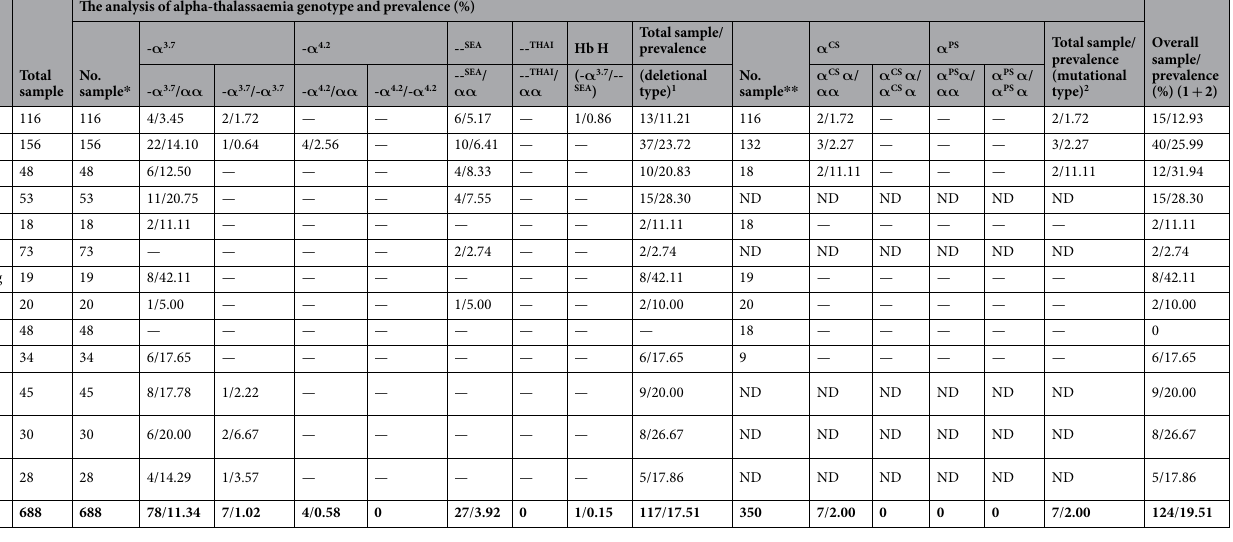
Table 1. The number of affected person according to the genotype analysis with prevalence (%) of α -thalassaemia in the population residing in northern Thailand. ND = Unverified point-mutational alpha- globin gene anomalies ( α CS , α PS ) by a dot-blot hybridization method. * The number of sample enrolled in this study was subjected to four deletional alpha-thalassaemia screening (- α 3.7 , - α 4.2 , -- SEA and -- THAI ). ** The number of sample enrolled in this study was subjected to four deletional (- α 3.7 , - α 4.2 , -- SEA and -- THAI ) and two mutational ( α CS , α PS ) alpha-thalassaemia